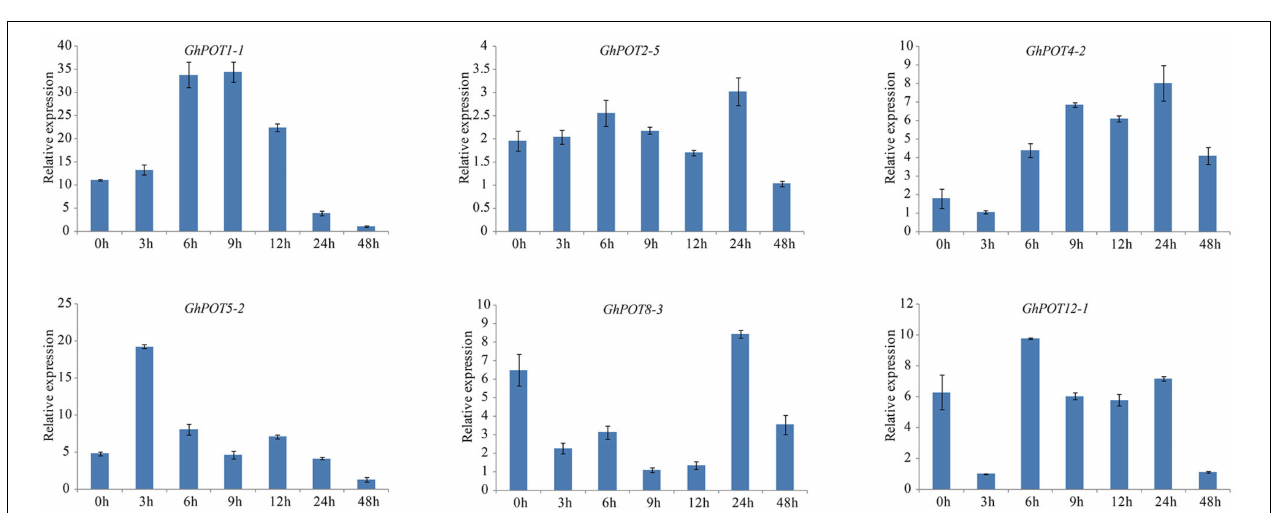
FIGURE 8 | Expressions of GhPOT genes in response to potassium deficiency stress (0.03 mM KCl). The expressions of the GhPOT genes were determined by qRT-PCR using the total RNA isolated from TM-1 leaves at different time points (0, 3, 6, 9, 12, 24 and 48 h) of dehydration stress. The error bars indicate the standard error (SE) of three biological replicates.